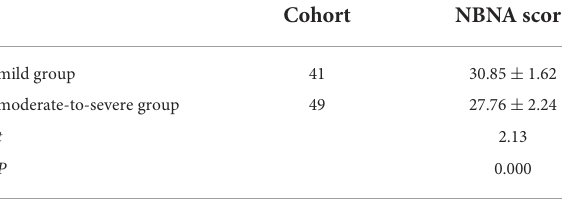
TABLE 2 Comparison of the NBNA value between two groups.